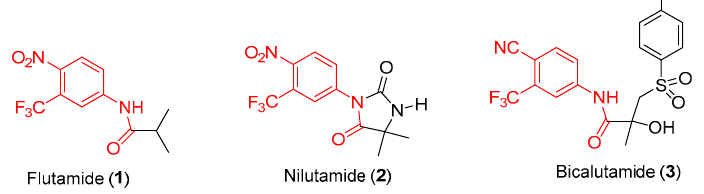
Figure 2. First generation of nonsteroidal AR antagonists.